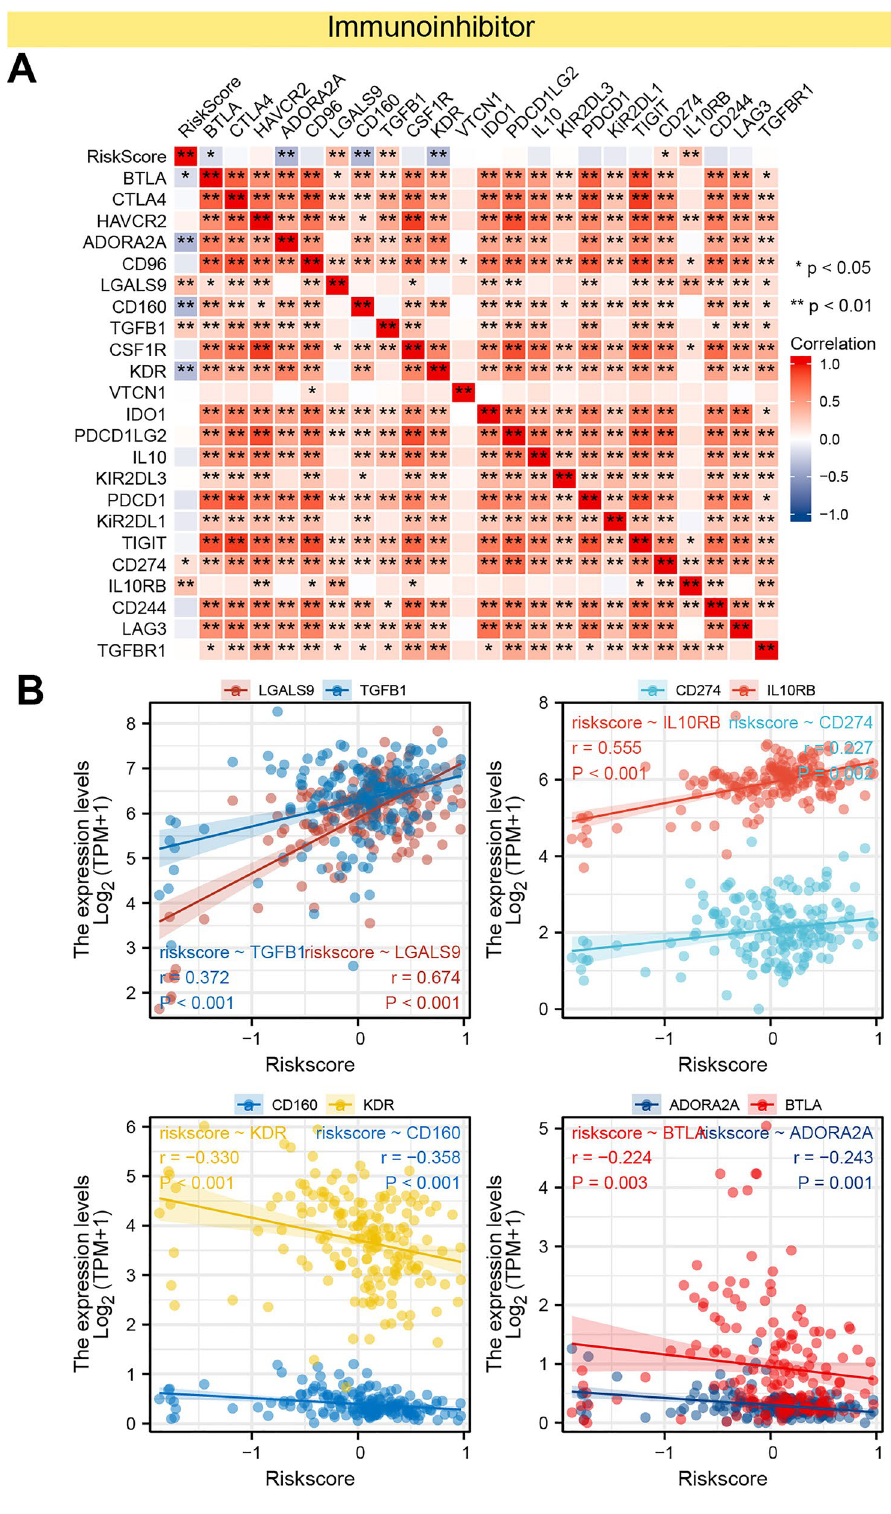
Figure 12. Analysis of correlation between PAAD-IRGS and immuno-inhibitors. ( A ) Immune-inhibitor genes—PAAD-IRGS heatmap; ( B ) correlation analysis of immune-inhibitor genes and PAAD-IRGS. * P < 0.05, ** P < 0.01, *** P <